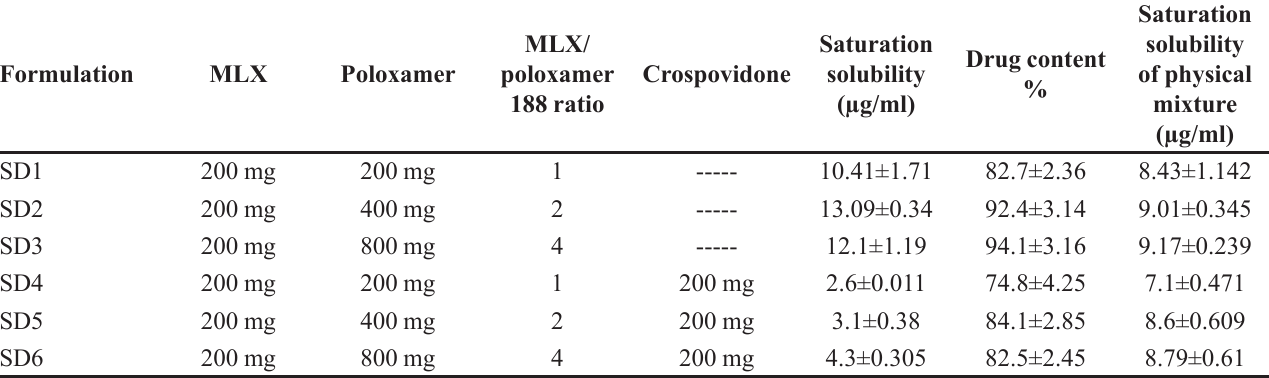
TABLE I - The amount of MLX, poloxamer 188 and crospovidone that utilized for preparation of MLX SDs and the